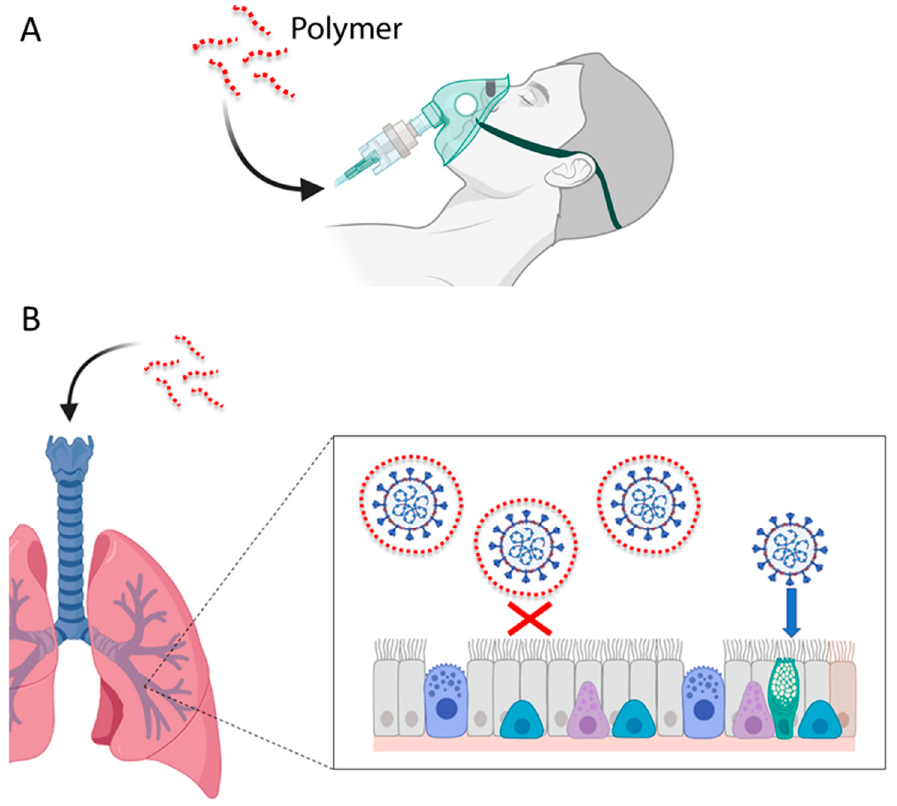
Figure 3. Alternative routes of administration of EPSs and other polyanions . ( A ) To overcome the low bioavailability of EPSs, new routes of administration should be tested, especially nebulization of aerosols to access pulmonary alveoli. ( B ) Aerial virions can be trapped by EPSs before attachment in the respiratory epithelium. To enter cells, viral glycoproteins must first attach to the host cell receptors. EPSs may block the viral glycoproteins and prevent viral entry (red cross).